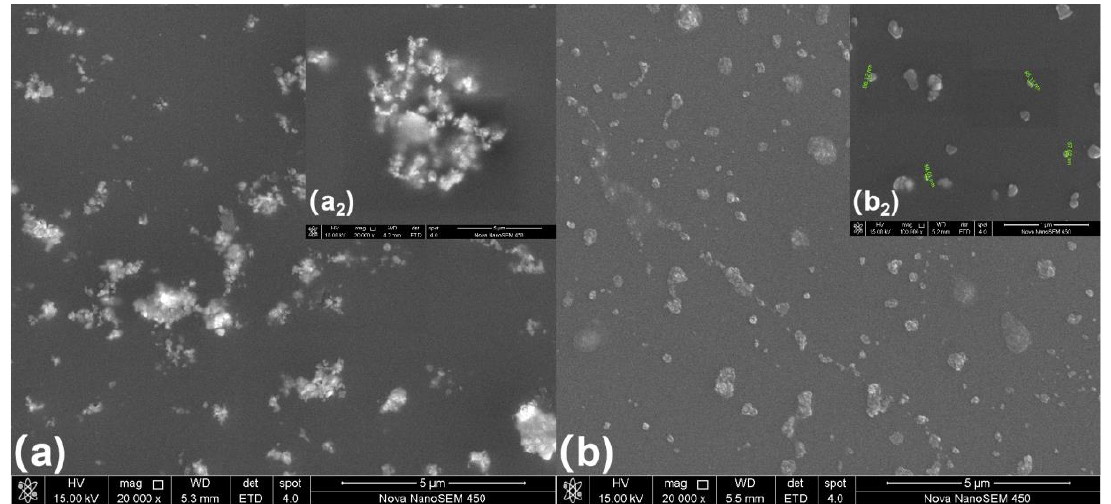
Figure 6. Morphology of composite coating: ( a ) the coating using unmodified WO 3 , ( b ) coating using milled WO 3 .